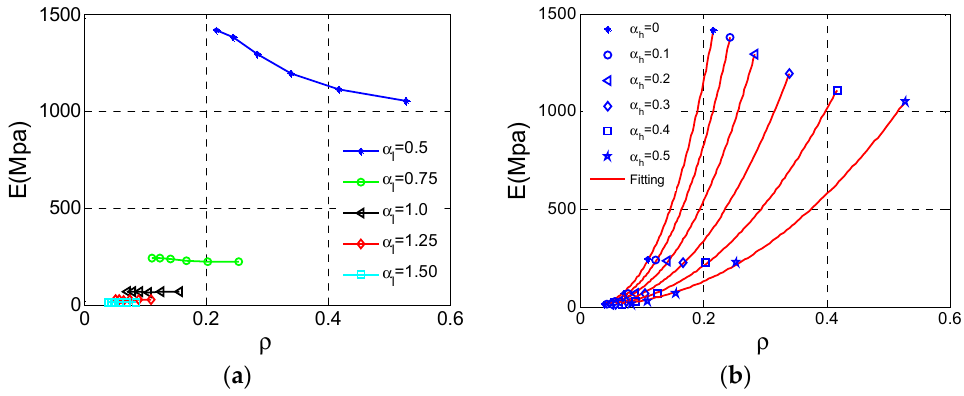
Figure 7. The changes of effective Young’s modulus E for Type A cell with respect to the relative density ρ : ( a ) data set; ( b ) fitting curves. Table 2. Fitting parameters of Type A cell analyses.